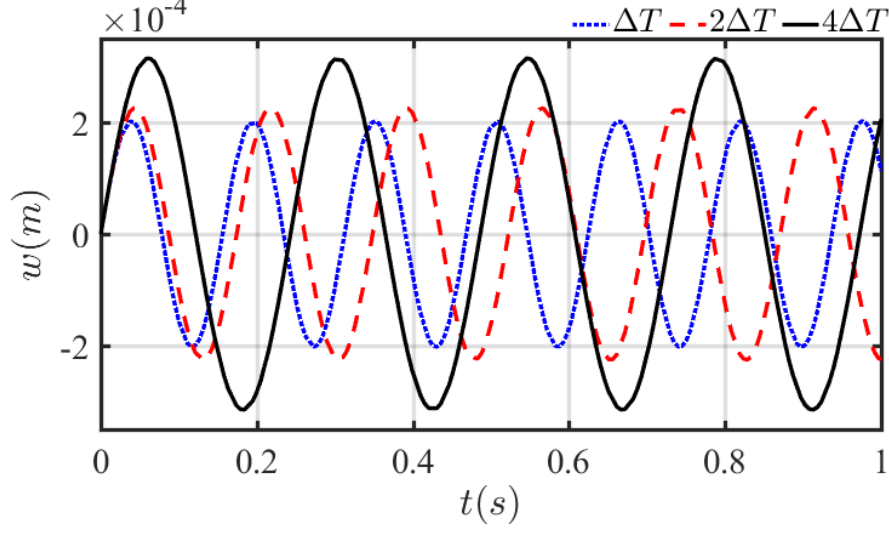
Figure 8. Effect of pressure peak index p on pipes conveying fluid nonlinear transient vibration.